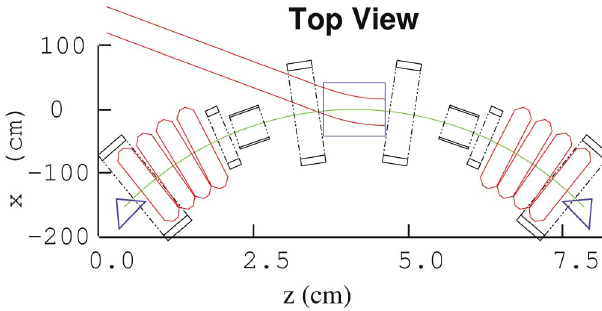
FIG. 17. (Color) View of the injection/extraction area in a RFOFO